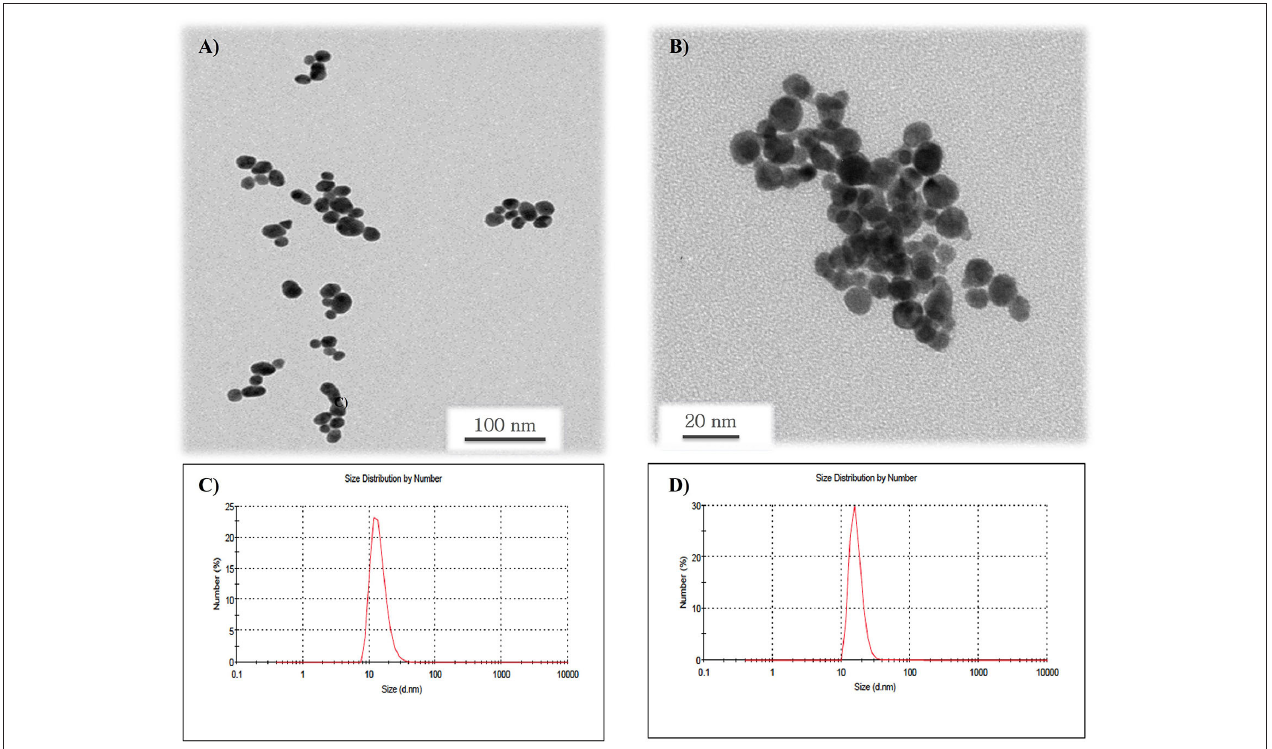
FIGURE 1 | TEM micrographs of AuNPs. (A) Image shows the spherical shape of the AuNPsGA dispersed in water with a mean particle size of 11.6nm ± 2.82; (B) image shows spherical AuNPsCA with a mean particle size of 15.8nm ± 3.56; (C) histogram shows the DLS size distribution of the AuNPsGA with a peak value of 14.4nm; and (D) histogram shows the DLS size distribution of the AuNPsCA with a peak value of 16.5nm.